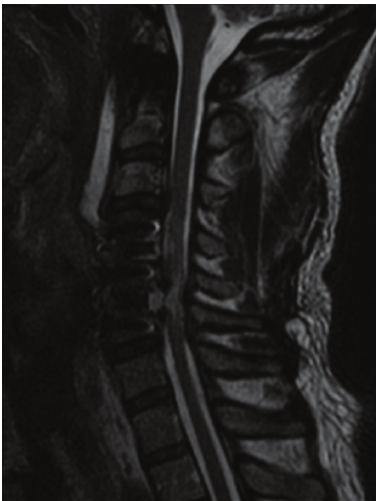
ACDF demonstrates residual C5